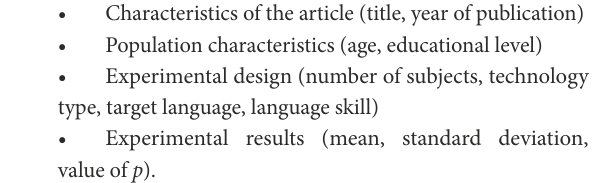
TABLE 1 Inclusion criteria for